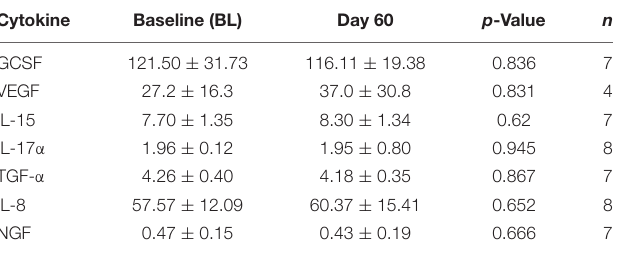
FIGURE 6 | Effects of a single 1-h TEMT treatment on plasma levels of four cytokines in AD subjects. For all four cytokines, if baseline blood levels were low (red points and lines), 1-h of TEMT induced an increase in plasma levels in samples taken several hours thereafter on Day 1. Conversely, if baseline cytokine levels were high (green points and lines), 1-h of TEMT resulted in decreased blood levels shortly thereafter on Day 1.